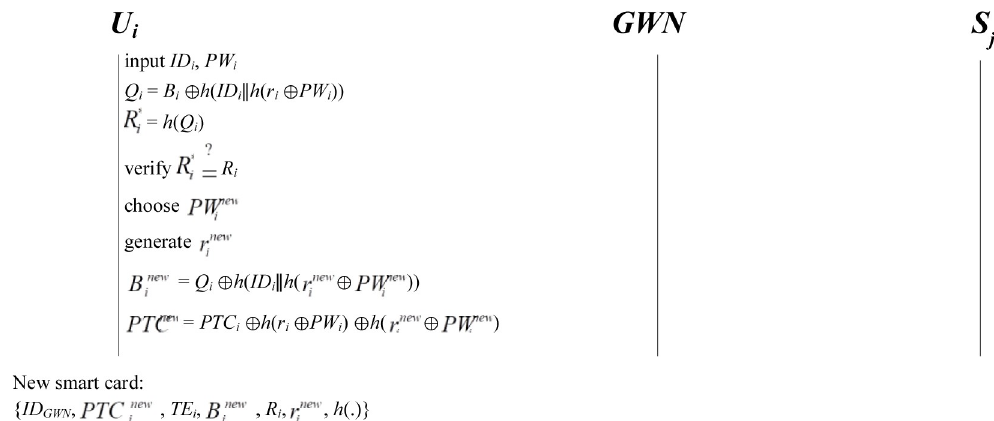
Fig 5. Password change phase in the proposed scheme ( U communication with the GWN and S j ).